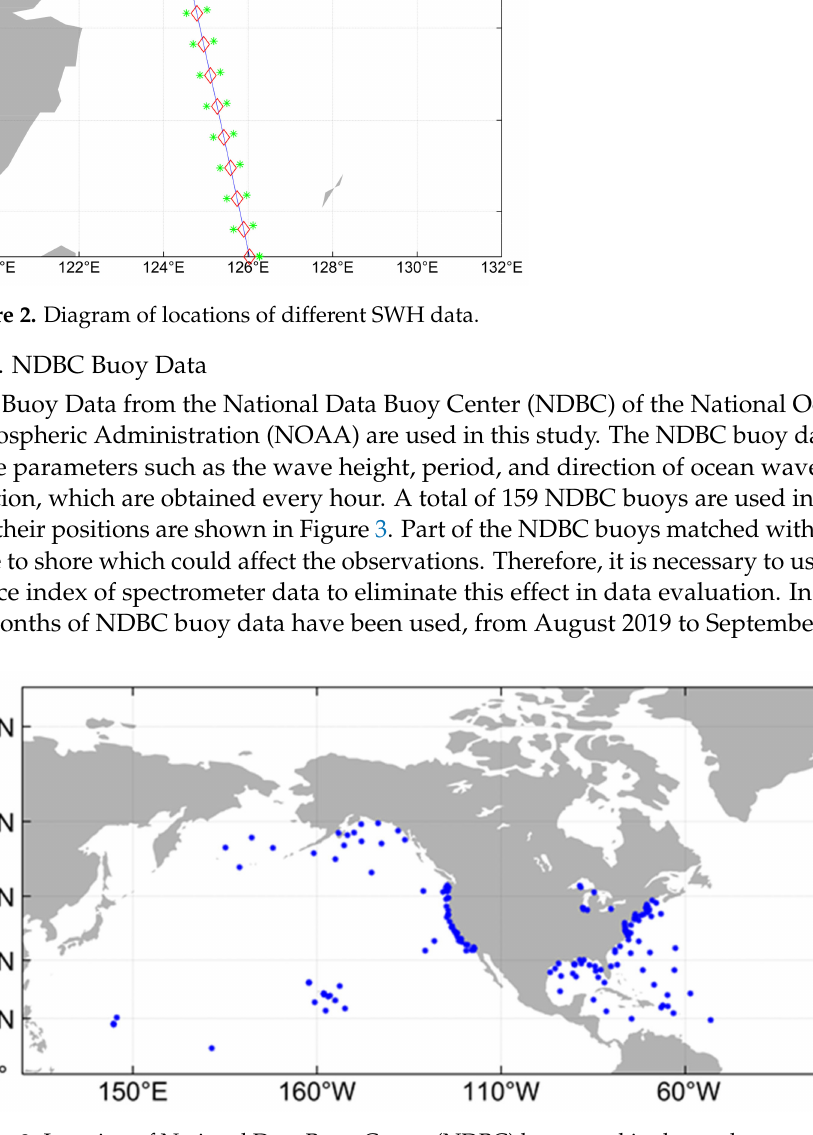
Figure 3. Location of National Data Buoy Center (NDBC) buoy used in the